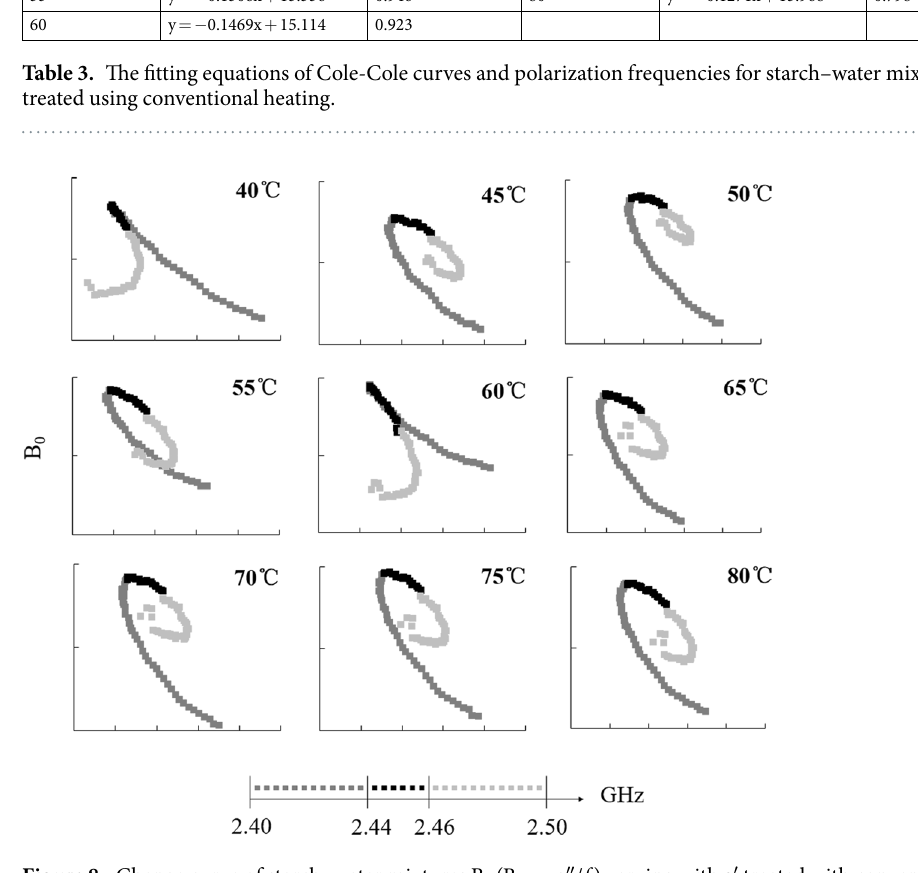
) varying with ε′ treated with conventional 0